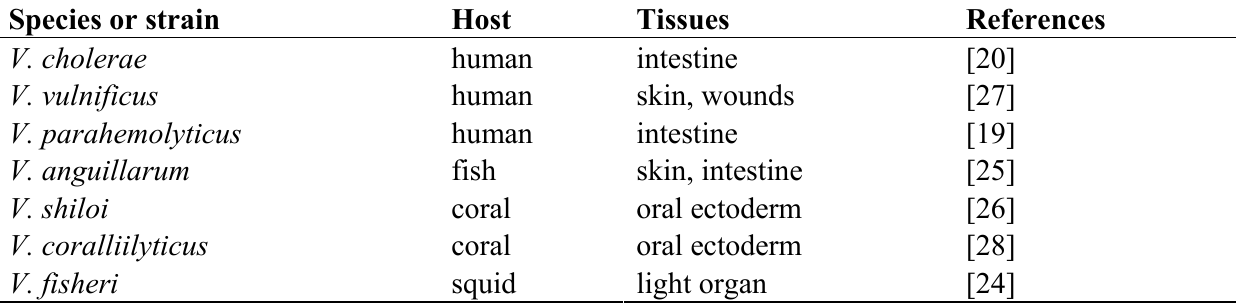
Table 1. Vibrios colonizing